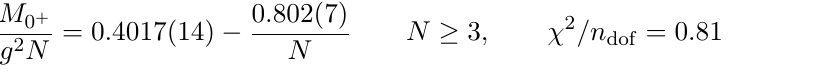
Table 28 . Continuum glueball masses in string tension units, M G = SO(6), with the (cid:31) 2 per degree of freedom of the linear extrapolation. Reliability as graded in tables